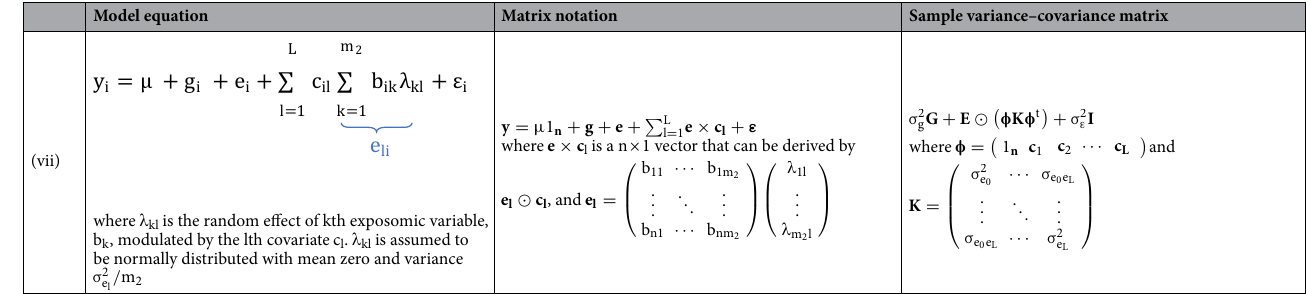
Table 2. Model equations and their assumed sample variance–covariance matrices.